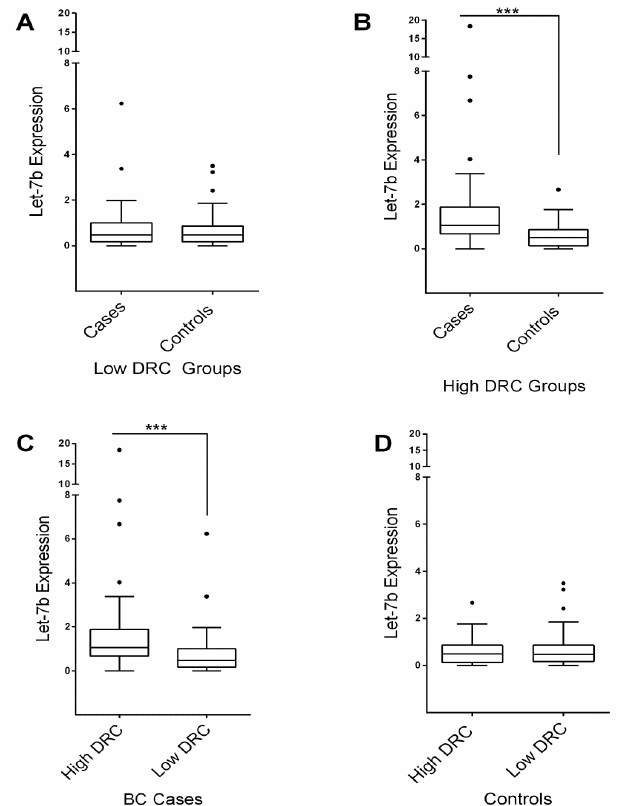
Figure 2. Let-7b expression measured in plasma samples of breast cancer patients and women without breast cancer (controls) with high and low DRC. ( A ) No significant differences were observed between the breast cancer patients ( n = 43) and the control group ( n = 37) with low DRC; ( B ) Statistically significant results were found between the breast cancer patients ( n = 35) and controls ( n = 39) with high DRC; ( C ) Comparison between breast cancer patients with high versus low DRC showed a significant difference in Let-7b expression; ( D ) No significant difference was observed when control groups with high versus low DRC were compared. Box plots represent the data distribution of 78 breast cancer patients and 76 controls in independent experiments. *** p < 0.001 using KW test.